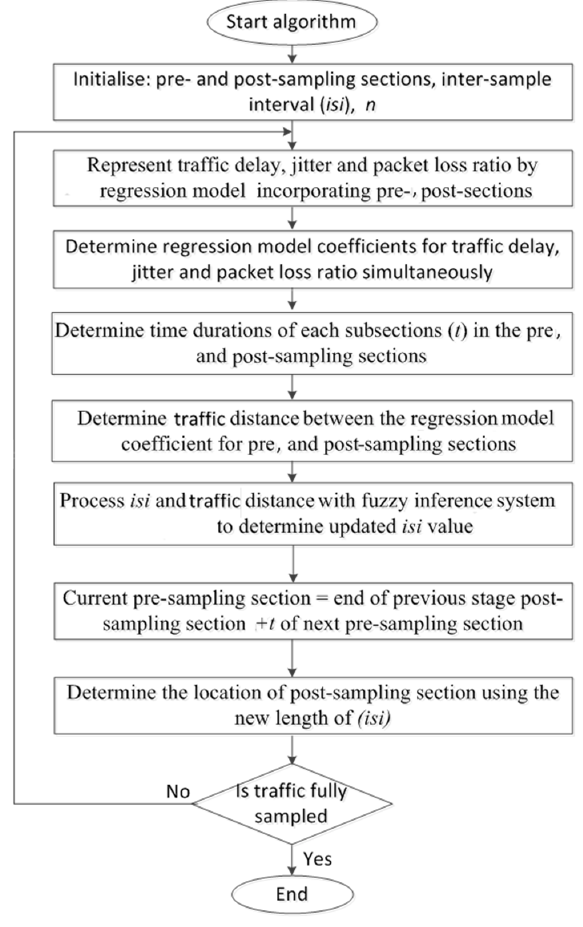
Figure 4. The flow chart of the adaptive sampling algorithm.